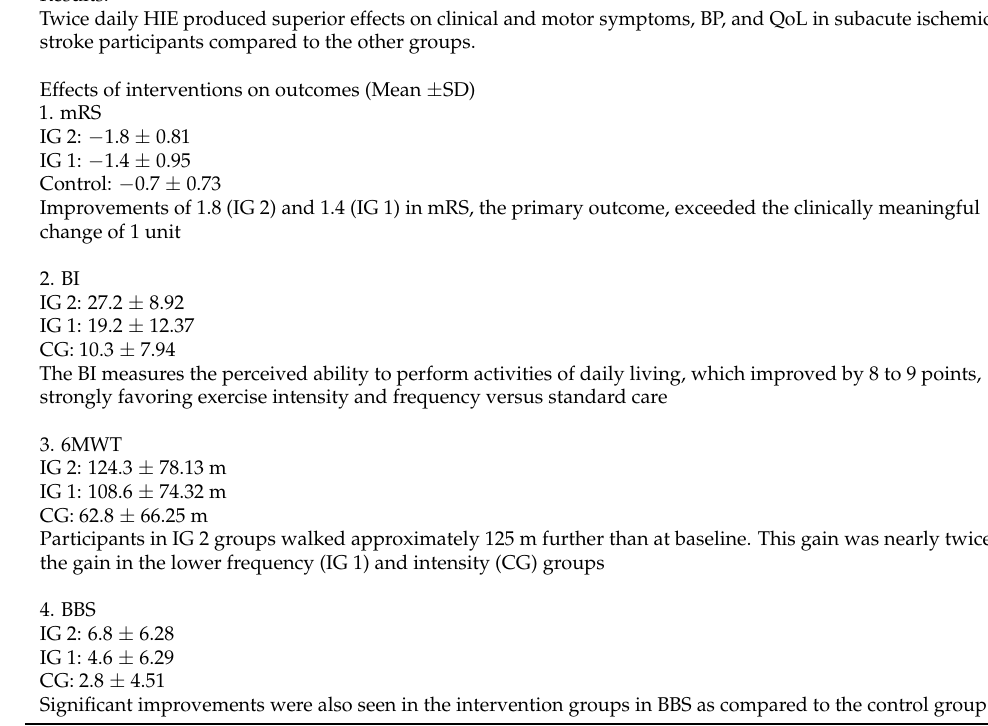
Table 1. Cont. Results: Twice daily HIE produced superior effects on clinical and motor symptoms, BP, and QoL in subacute ischemic stroke participants compared to the other groups. Effects of interventions on outcomes (Mean ± SD) 1.